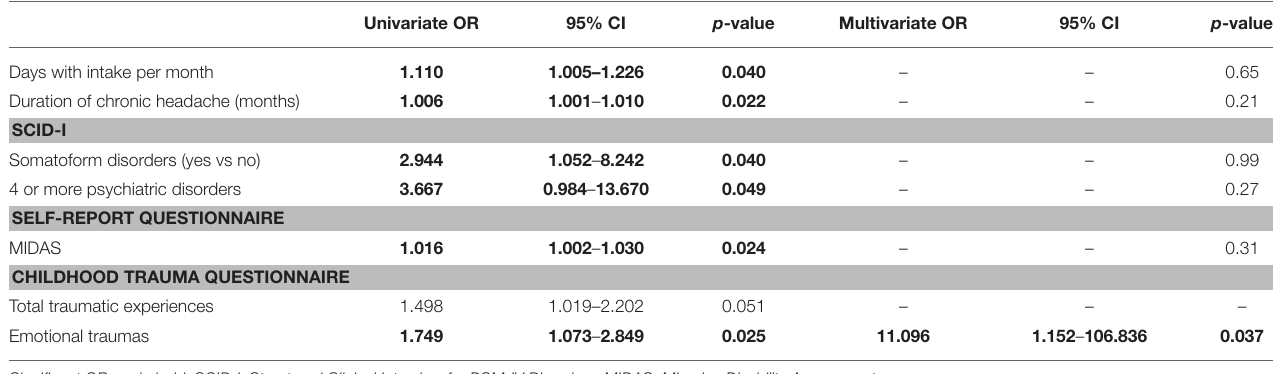
TABLE 3 | Model fit of logistic regression equations to predict persistence of overuse at 2 months after detoxification.